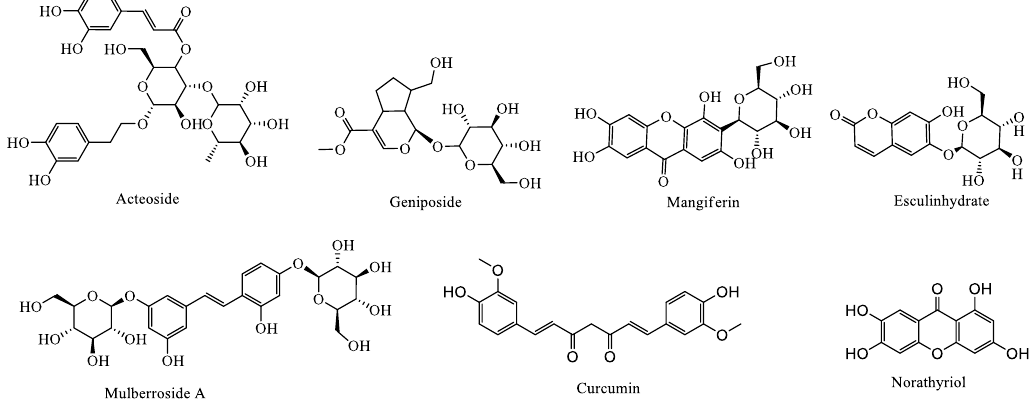
Figure 6. The basic structure of hypouricemic effects from other bioactive components in plant-based functional foods.